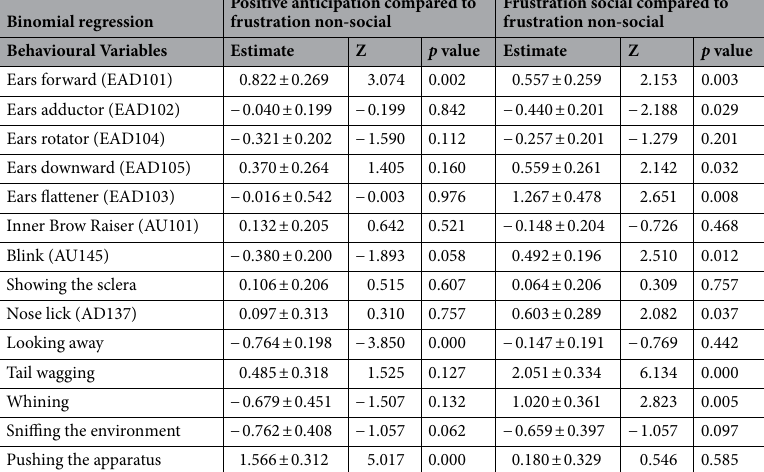
Table 2. Main Results of the Binomial